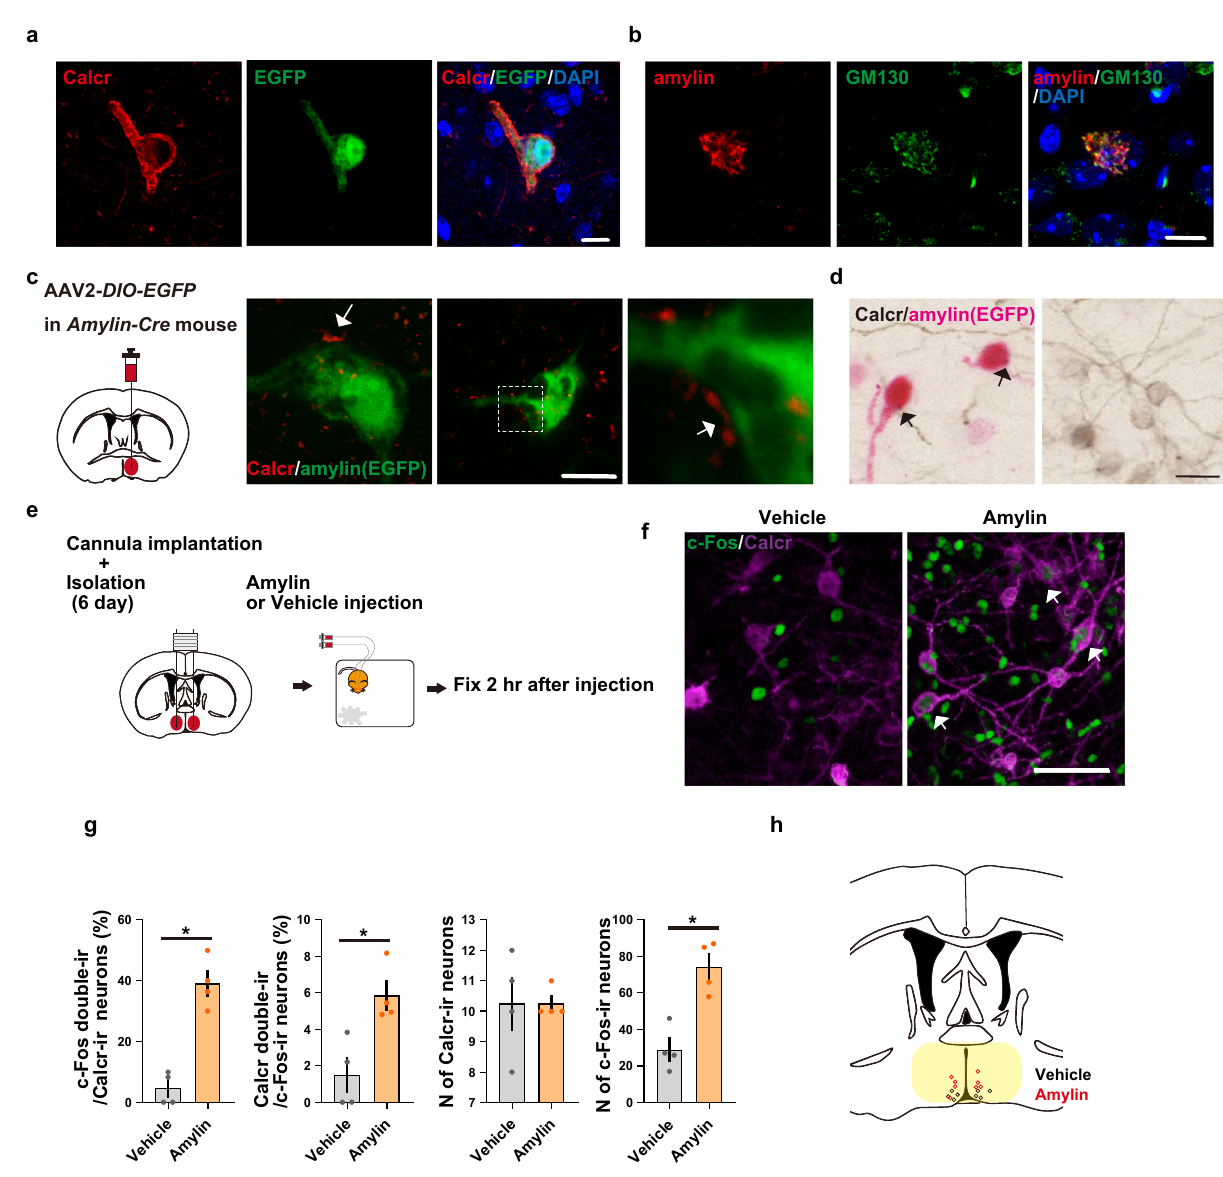
Fig. 7 Spatial relationship between Calcr + and amylin + neurons and the activation of Calcr + neurons by amylin. ( a ) Localization of Calcr (red) on the plasma membrane of EGFP + neurons (green). Coronal sections of the cMPOA were stained with anti-Calcr antibodies and DAPI (blue). Scale bars, 10 μ m. ( b ) Amylin localization in the Golgi apparatus. Sections were stained with antibodies recognizing amylin (red) and GM130 (green), a cis-Golgi matrix protein. Scale bars, 10 μ m. ( c, d ) The anterograde fi bers of Calcr-immunoreactive (Calcr-ir) neurons lie in the vicinity of amylin + neurons (green). Coronal sections of the MPOA of group-housed Amylin-Cre female mice injected with Cre-dependent EGFP AAV vector into the cMPOA. Sections were stained with anti-Calcr (red or black) antibodies. Images were taken with confocal ( c ) or bright- fi eld ( d ) microscopes. Scale bars, 10 μ m ( c ) and 25 μ m ( d ). ( e ) Experimental procedure. Six days before amylin infusion, group-housed female mice were equipped with guide cannula and single-housed. Two hours after local amylin or vehicle infusion in vivo, the mice were subjected to perfusion fi xation for immunochemical studies. ( f ) Distribution of Calcr (magenta) and c-Fos (green) in the cMPOA with or without amylin infusion. Arrowheads indicate double-labeled cells. Scale bar, 50 μ m. ( g ) Percentage of Calcr-ir neurons expressing c-Fos, percentage of c-Fos-ir neurons expressing Calcr, number (N) of Calcr-ir and c-Fos-ir neurons in the MPOA after amylin infusion ( n = 4 mice per group). ( h ) Schematic coronal section showing the location of the injection cannula tips. Black (red) circles indicate individual cannula tips used for vehicle (amylin) infusion. The yellow zone corresponds to the assumed spreading area of the injected blue dye. Asterisks indicate signi fi cant differences between two groups (Mann-Whitney U test, two-sided, * p < 0.05). Graphs show mean ± SEM. See Supplementary Data for exact p values and details of statistical from video recordings. The hunched posture, in which mice tuck their feet beneath Direct social behaviors were not coded as they cannot be displayed by isolated the body with their back hunched up, and crouch posture, in which mice tuck their mice. The behaviors and the mouse position (in contact with the partition, in the feet beneath the body without their back hunched up, were scored in a one-zero half compartment near the partition, or in the half compartment away from the fashion using still images extracted at 1-min intervals for 3-h. partition; see Fig. 2a) in the cage were scored using video recordings at 15-s Two days after somatic isolation, the real partition was replaced by the sham intervals for 30 min. In addition, the biting behavior, i.e., the mice bite the window partition for reunion. The social contacts made by the formerly isolated mice with frames of the real partition with their head tilted, was scored in a one-zero fashion conspeci fi cs were assessed using still images extracted by Batch Video to Image from still images extracted at 15-s intervals for 3h (Fig. 2) or 2h (Figs. 6, 8, S5, S8)